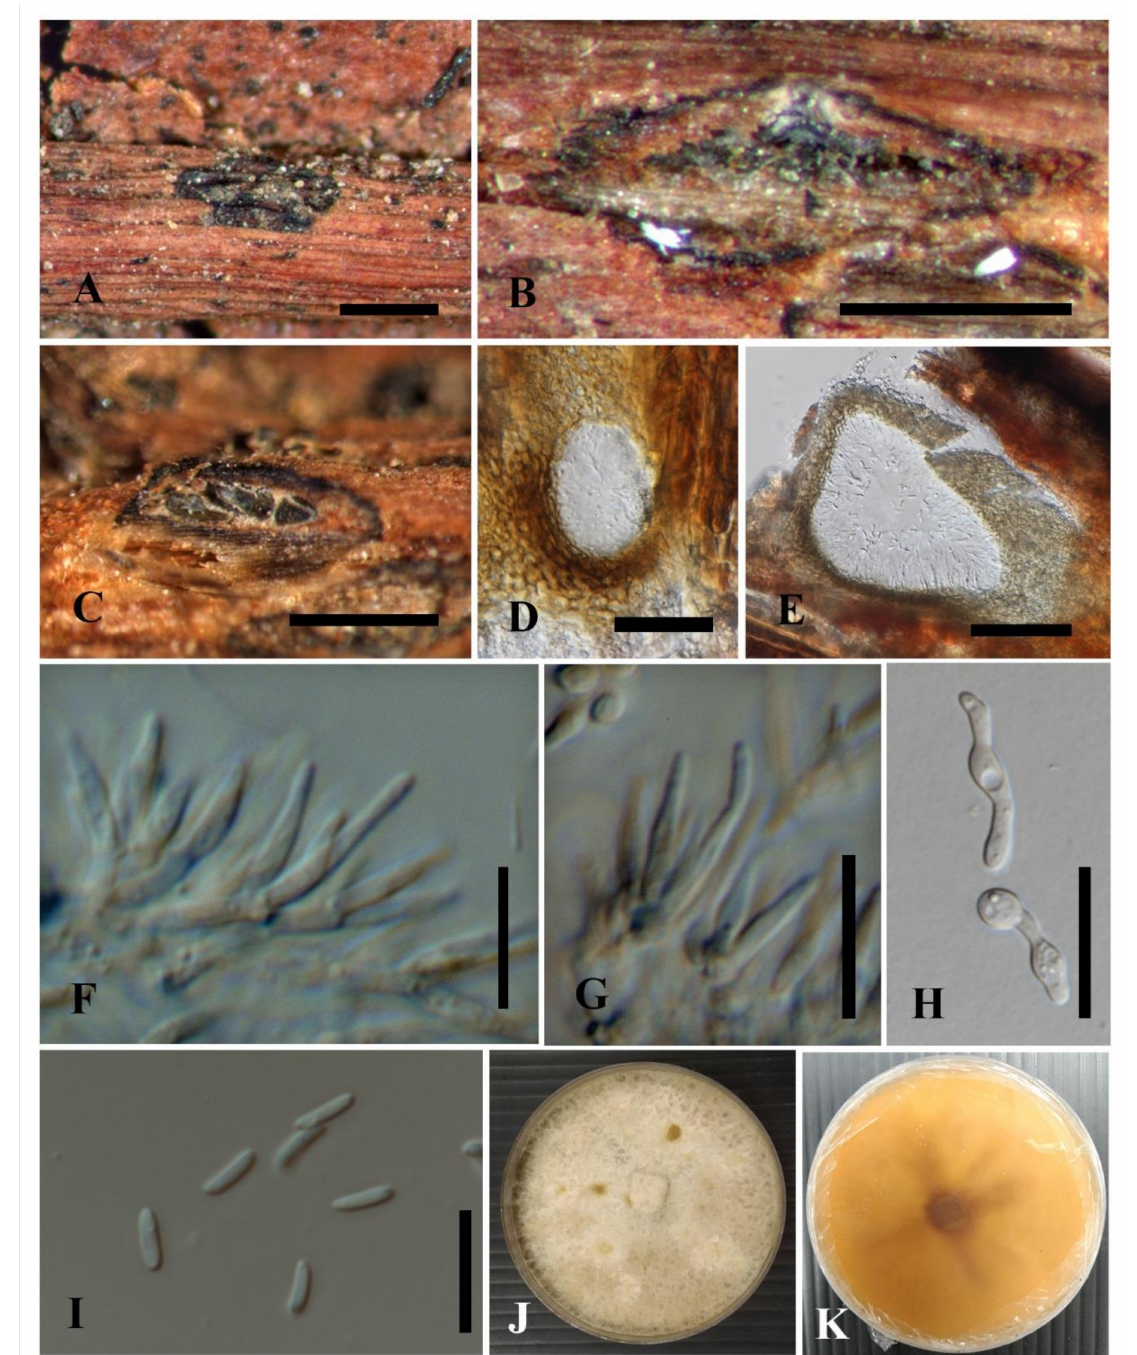
Figure 6. Cytospora phitsanulokensis (MFLU 21-0051, holotype). ( A ) Conidiomata on host substrate. ( B,C ) Longitudinal sections through conidioma. ( D,E ) Longitudinal sections of locules. ( F,G ) Conidiophores and conidiogenous cells with attached conidia. ( H ) Germinating conidia. ( I ) Conidia. ( J,K ) Colonies on PDA plate (9 cm diam.) (( J ) from above, ( K ) from reverse). Scale bars: ( A – C ) = 500 µ m, ( D ) = 30 µ m, ( E ) = 50 µ m, ( F – I ) = 10 µ